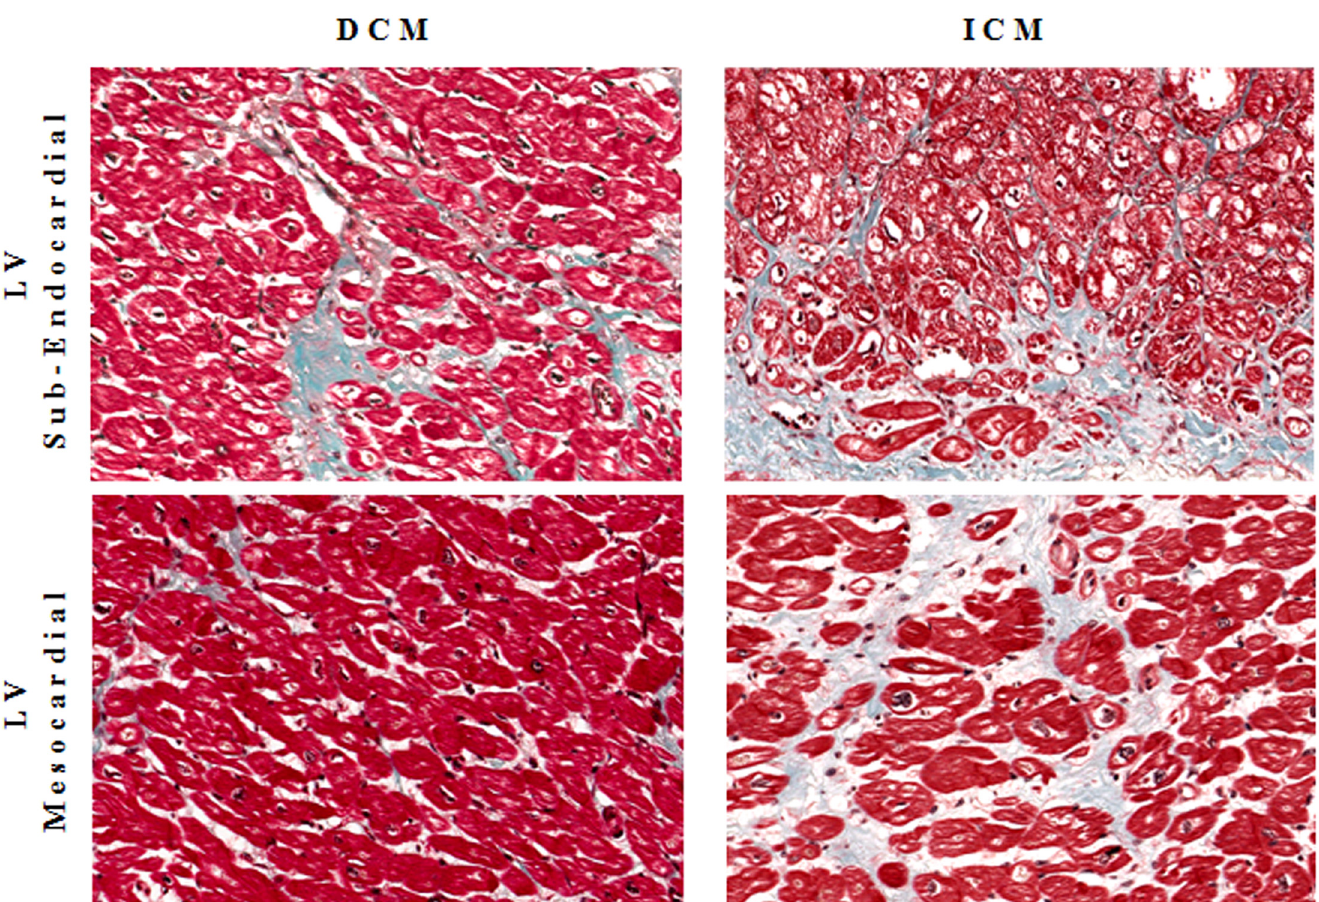
Fig 6. Histology. Histological representation (Masson ’ s trichrome) of left ventricular mesocardial and sub-endocardial layers in DCM (left) and ICM (right).